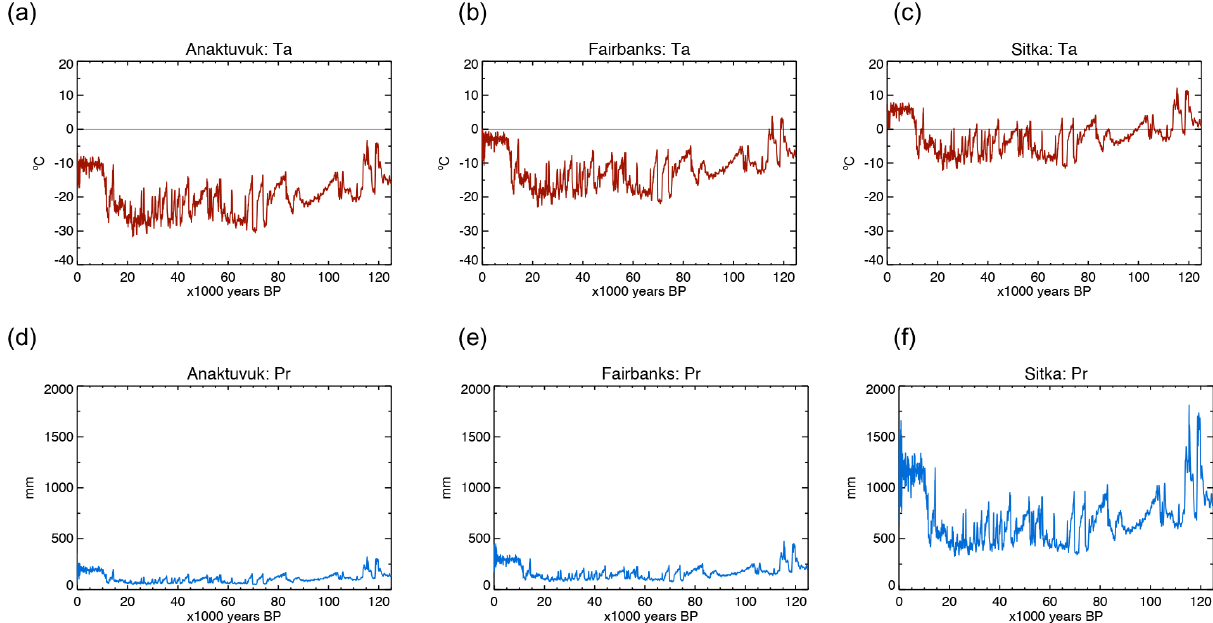
Figure 4. Example time series of climate forcing data (temperature, precipitation). The temporal variations in climate forcing data were reconstructed from Greenland ice core data (the SeaRISE project), while present-day climatology at the 1 ◦ grid point was derived and interpolated from ERA-Interim reanalysis. Mean annual air temperature ( T a ; in ◦ C) at the Alaskan grid point closest to (a) Anaktuvuk (69.5 ◦ N), (b) Fairbanks (64.5 ◦ N), and (c) Sitka (57.5 ◦ N). Panels (d–f) are the same as panels (a–c) except for annual total precipitation (Pr; in